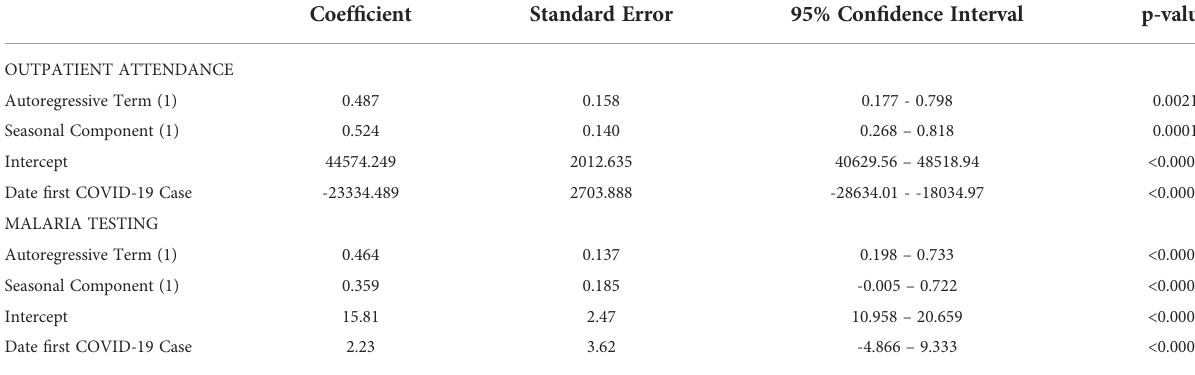
TABLE 2 Outputs of best fi tting time series models with a 12-month periodicity for outpatient visits (ARIMA (1,0,0) (1,0.0) (12)) adjusting for the date of fi rst COVID-19 diagnosis in the country and malaria testing rates per 1000 outpatient visits, adjusting for COVID-19 testing timeseries in Cabo Verde (ARIMA (1,0,0) (1,0.0) (12)).